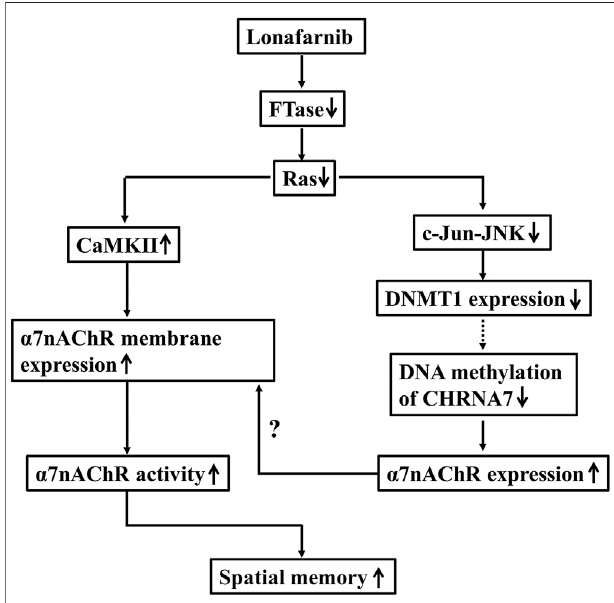
FIGURE 7 | The hypothesis of molecular mechanism underlying the lonafarnib-upregulated α 7nAChR. ↑ : increase; ↓ : decrease; dotted line meant hypothesis need to be con fi